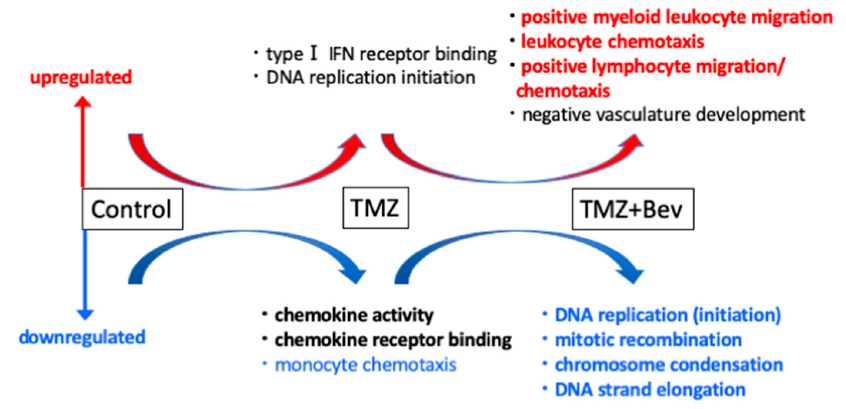
Figure 2. Gene Ontology analysis. ( a ) Addition of Bevacizumab (Bev) to Temozolomide (TMZ) upregulated genes for extracellular matrix organization and immune response in IDH1 -mutant U87 cells. ( b ) Addition of Bev to TMZ downregulated genes for cell cycle progression in IDH1 -mutant U87 cells.